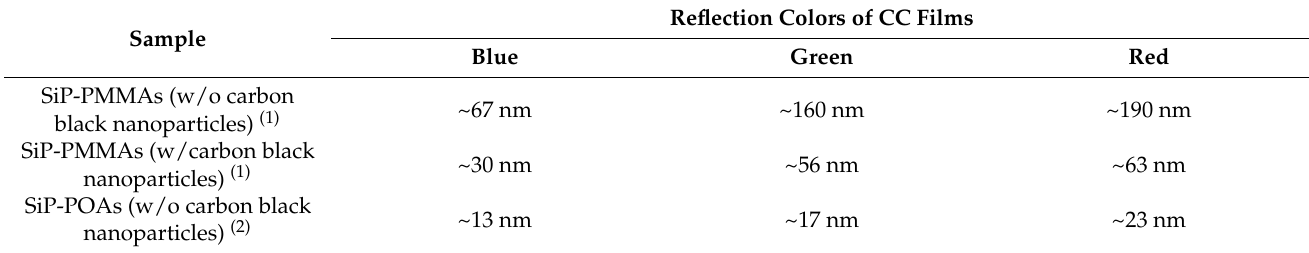
Table 3. Quantitative comparison of the FWHM values in reflection bands of CC films fabricated with SiP-PMMAs and